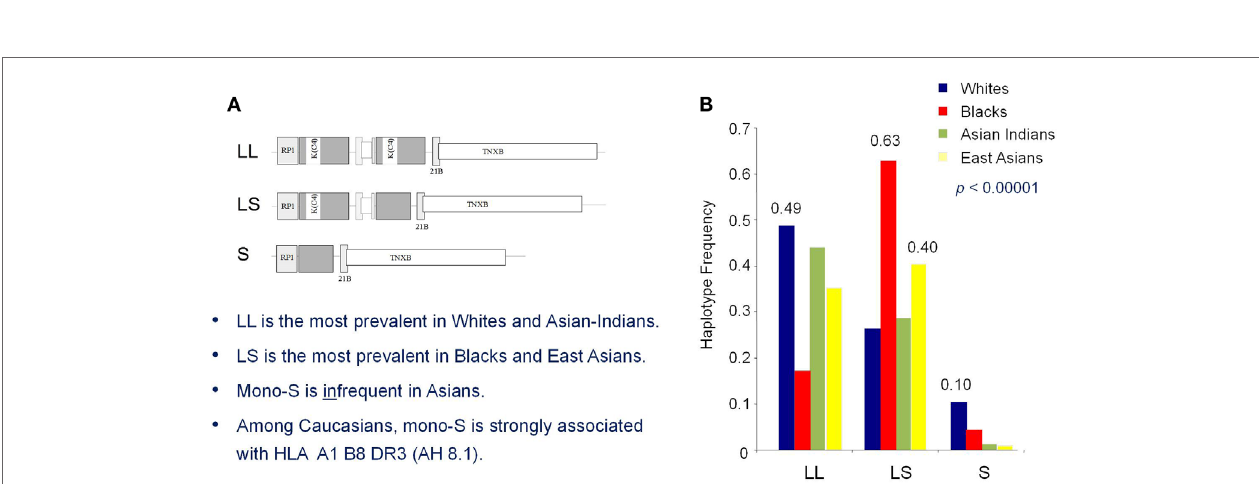
FiGURe 6 | Race-specific distribution patterns of RCCX modules in human populations . The size dichotomy of C4 genes and copy-number variation of RCCX modules on an MHC haplotype together create a repertoire of length variants among different human subjects, which also exist with race-specific distribution patterns. (A) The most prevalent haplotypes of RCCX in Whites and Asian-Indians are the bimodular long-long (LL) and bimodular long-short (LS) in Blacks and East-Asians. (B) Notably, monomodular-short (mono-S or S) haplotypes with a single short C4B gene and C4A deficiency is relatively common in White and Black subjects but almost absent in Asians [modified from Ref. (118)].